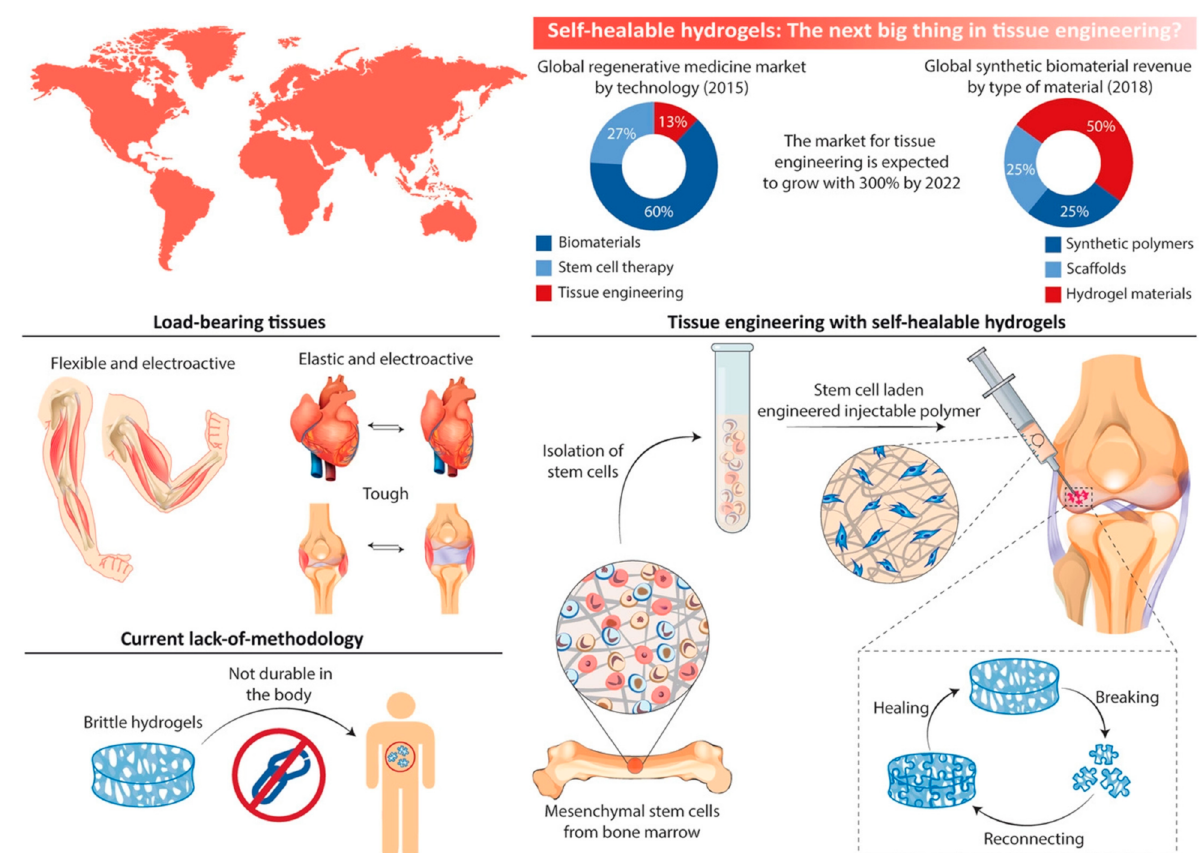
Figure 6. Applications of self-healing hydrogel in various tissue engineering applications. This figure is adopted form Talebian et al. [12]. “This study is under Creative Commons Attribution 4.0 International License, which permits use, sharing, adaptation, distribution, and reproduction in any medium or format, as long as you give appropriate credit to the original author(s) and the source as well as provide a link to the Creative Commons license (http://creativecommons.org/licenses/by/4. 0/, accessed on 19 October